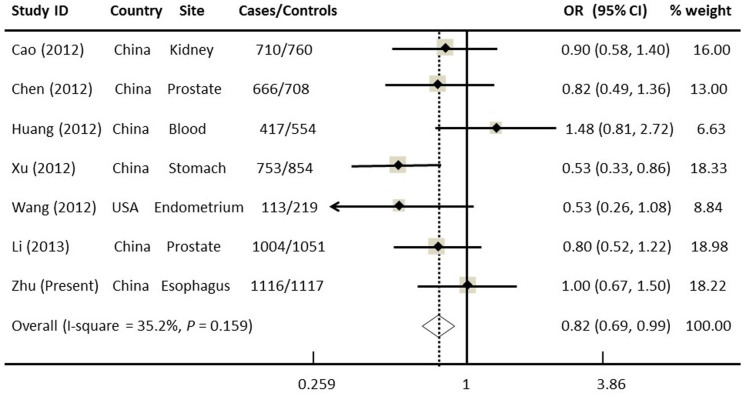
Forest plot of overall cancer risk associated with mTOR rs2295080 (a genetic recessive model).This was derived from a meta-analysis of seven relevant case-control studies. The OR and 95% CI of each study are plotted with a box and a horizontal line. Quadrangles represent pooled ORs and 95% CIs; Chi2, chi-square; df, degrees of freedom; I2, index of heterogeneity.